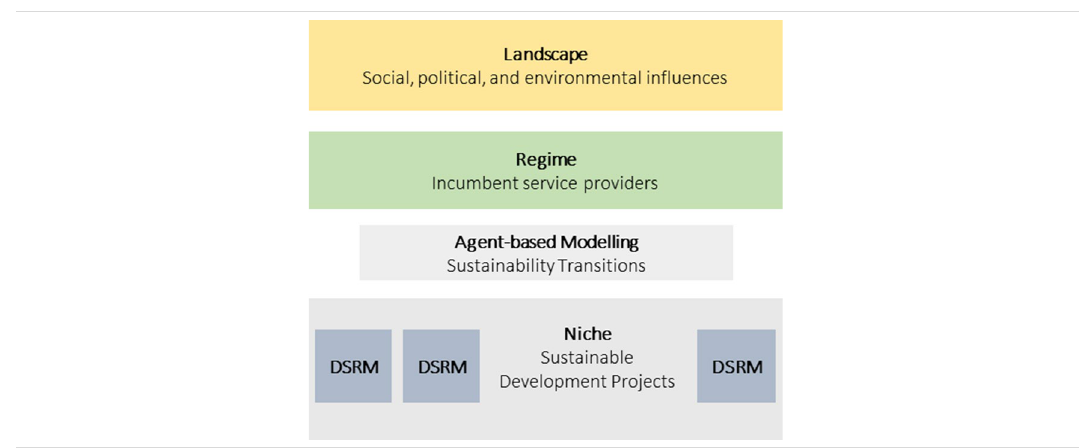
Fig. 8 Integration of DSRM and ABM into